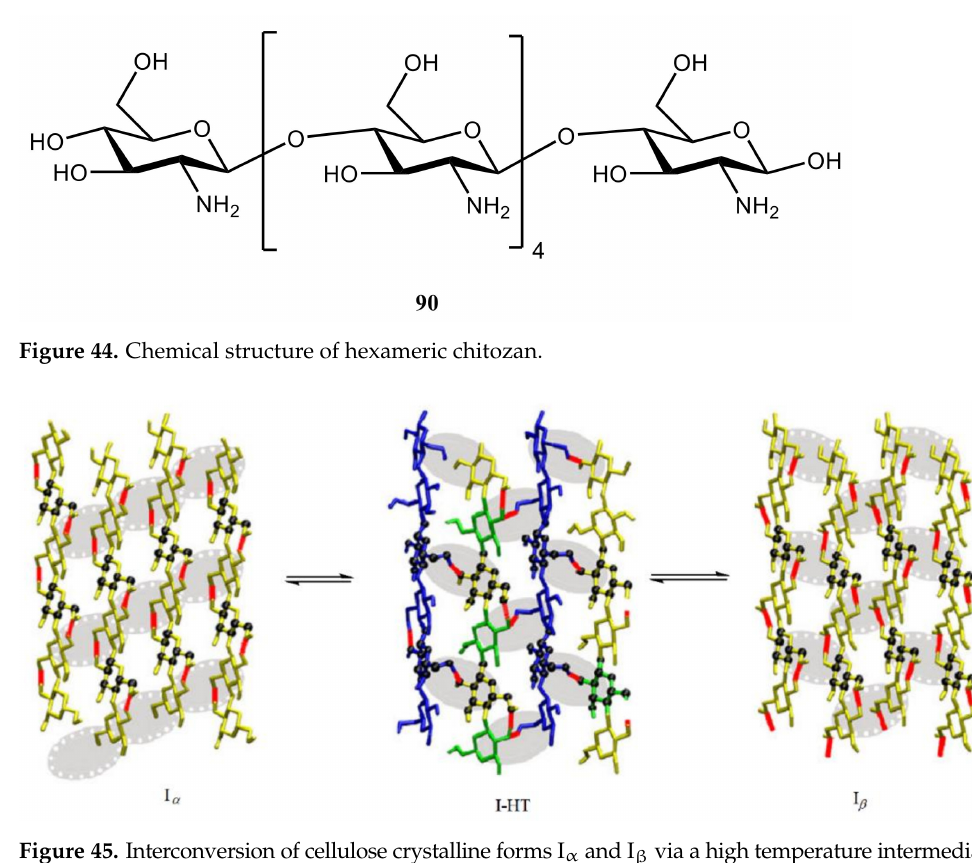
Figure 45. Interconversion of cellulose crystalline forms I α and I β via a high temperature intermediate I-HT. For details, see cited paper. Reproduced with minor editing privilege from Matthews et al. [156] with the permission of Springer